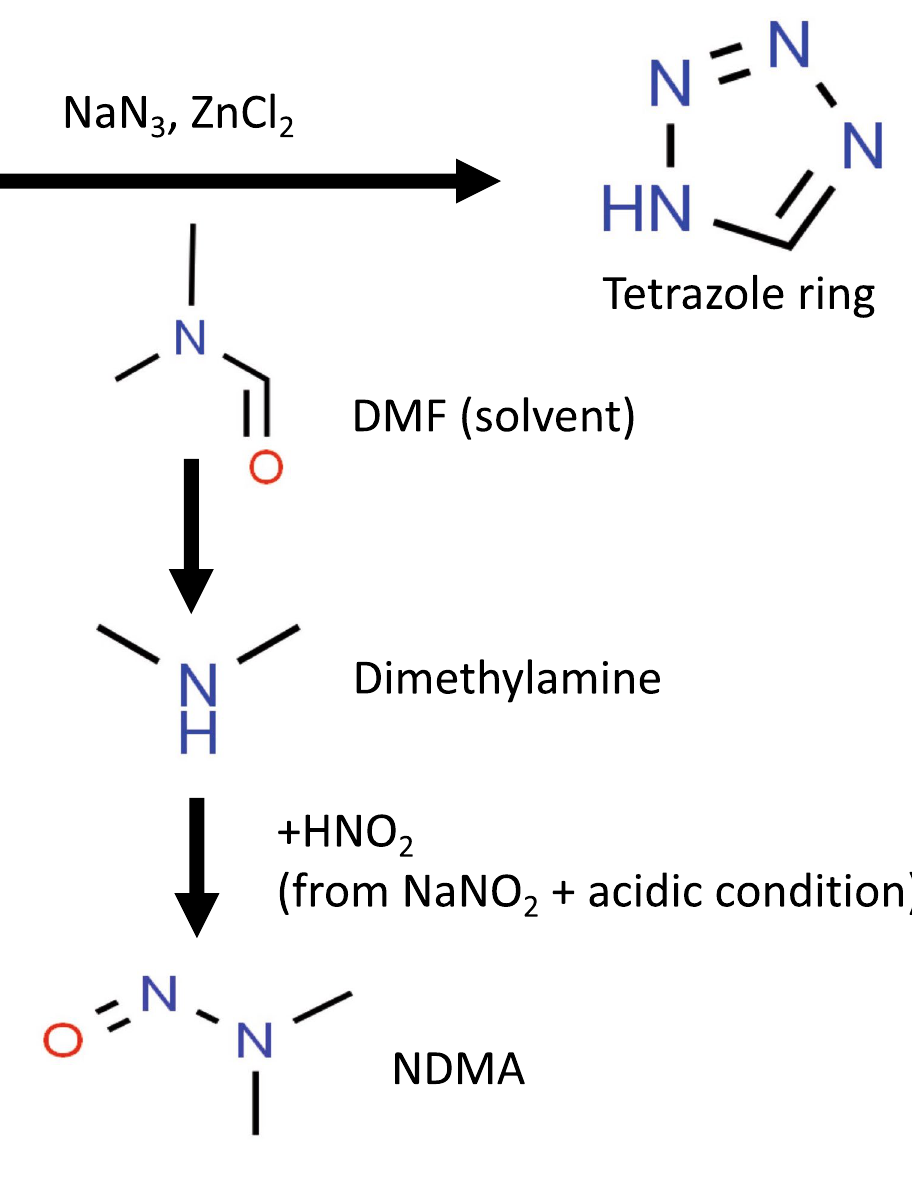
Figure 4. Proposed chemistry of NDMA formation from DMF during sartan production. The active pharmaceutical ingredient in sartan drugs has a tetrazole ring and the conventional method to produce this ring was reported to be slow. In order to accelerate the production process, a synthesis procedure that uses the solvent, dimethylformamide (DMF) and sodium azide (in place of tributyltin azide) was introduced in 2012. During tetrazole synthesis, a small amount of dimethylamine would be formed from DMF. The synthetic process also involves the use of nitrous acid to dispose of the excess sodium azide. This nitrous acid (a nitrosating agent) which is produced from sodium nitrite under acidic conditions can react with dimethylamine to form NDMA. (R = aryl, alkyl or vinyl; DMF = dimethylformamide; NDMA = N-nitrosodimethylamine). Figure adapted from 2,53–55